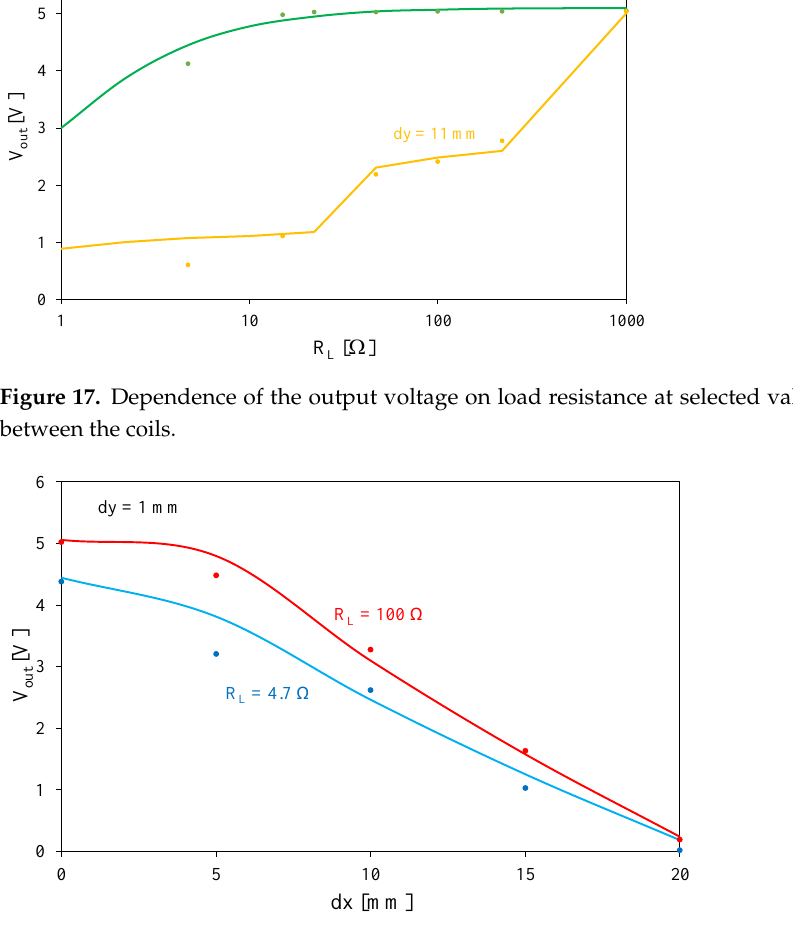
Figure 18. Dependence of the voltage at the receiver and at the transmitter on the distance between the transmitting and receiving coils in relation to the X axis for two values of load resistance.